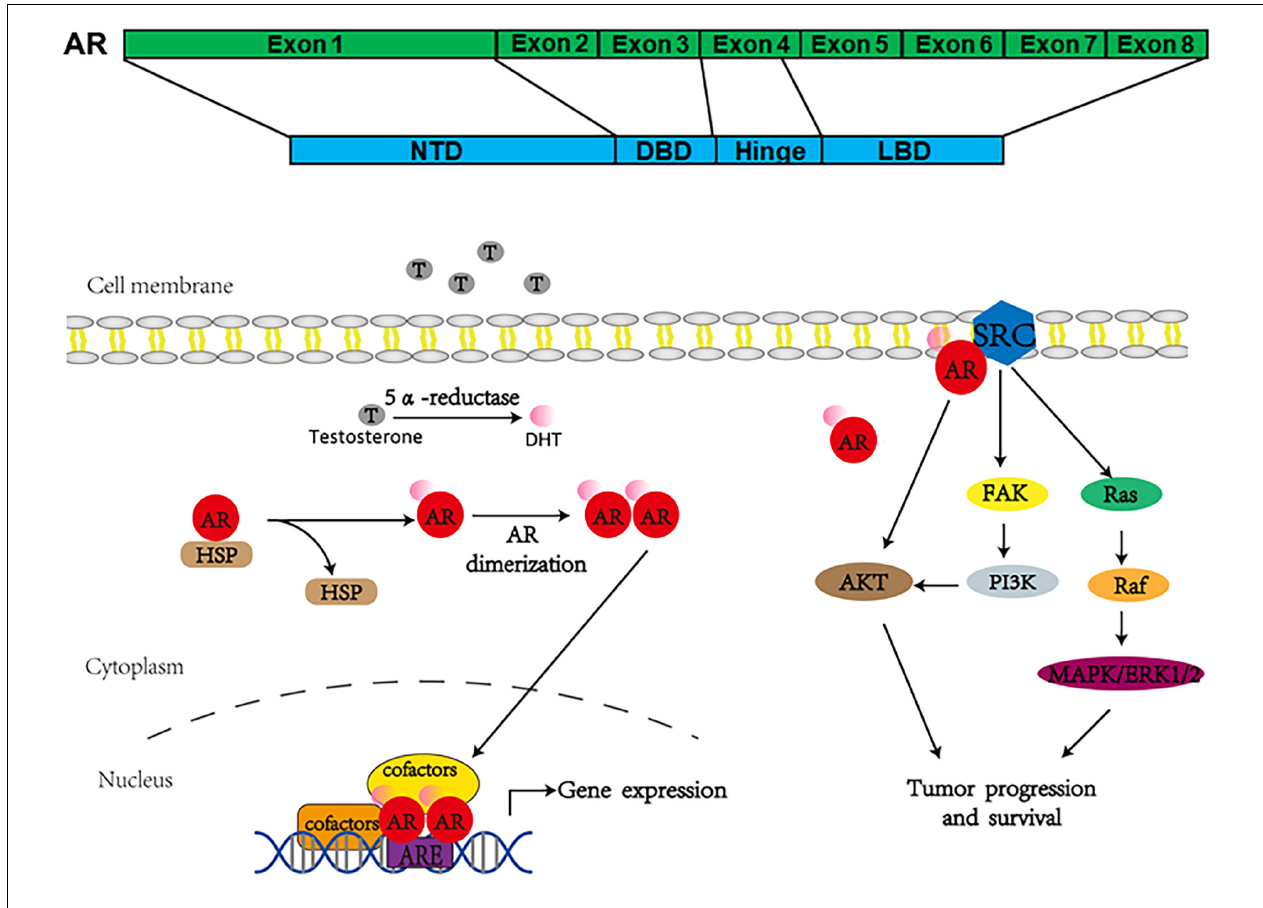
FIGURE 1 | Androgen receptor’s structure and how it works to regulate gene